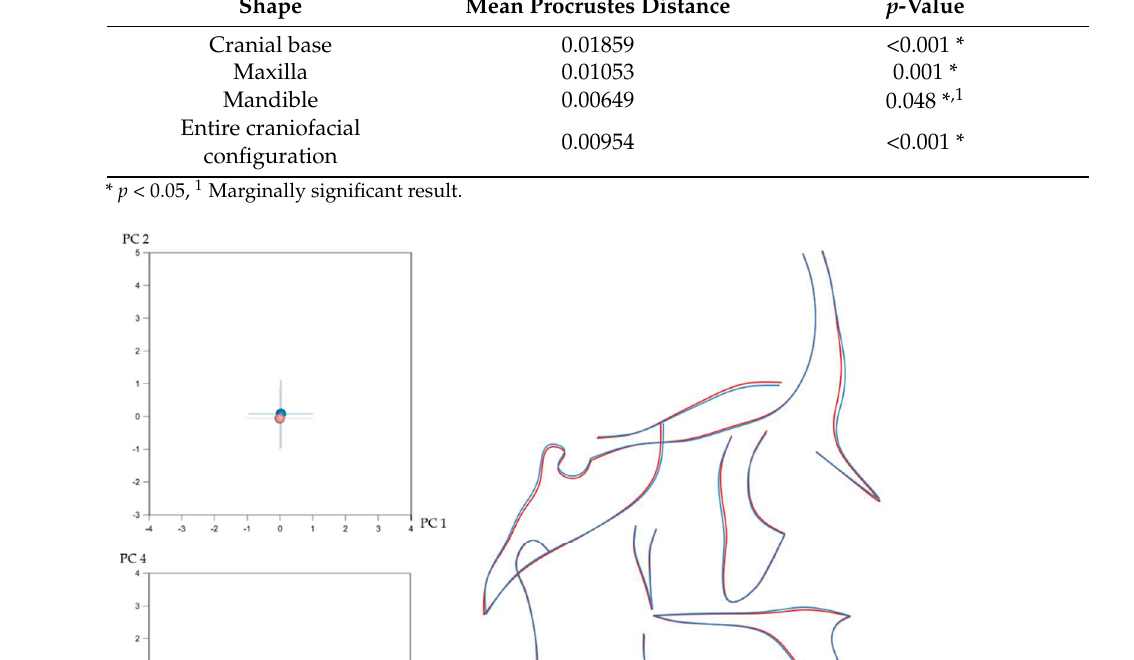
Table 1. Shape differences between male and female craniofacial configurations. Shape Mean Procrustes Distance p -Value